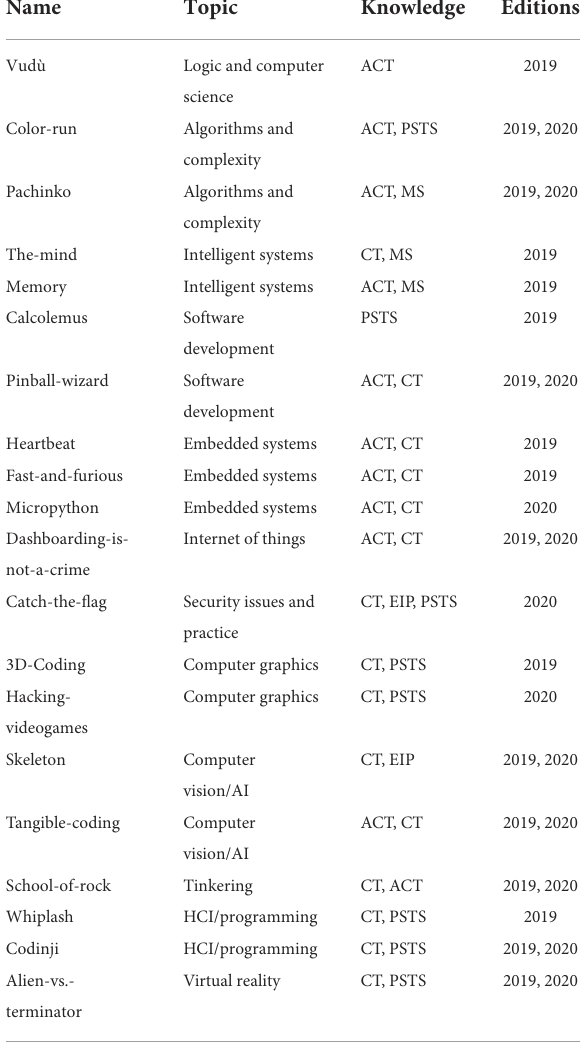
TABLE 2 Knowledge elements from the ACM/IEEE Computing Curricula